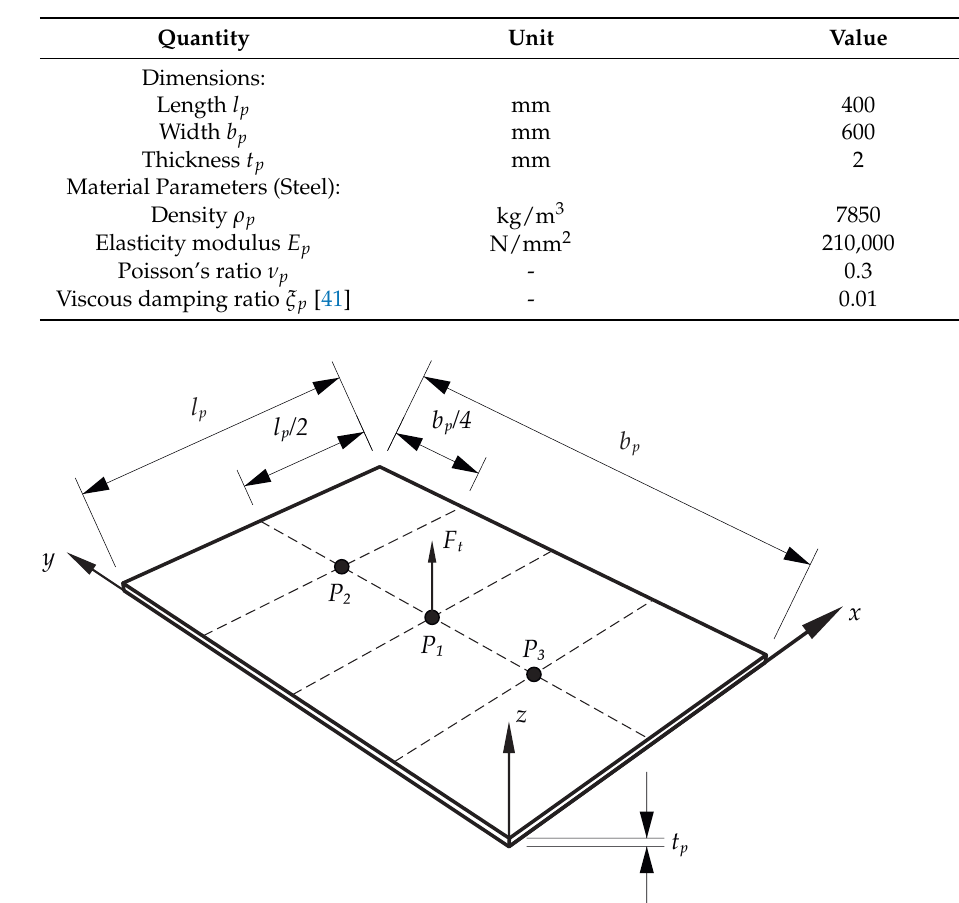
Figure 3. Model of the vibrating plate with its dimensions, characteristic points P 1 to P 3 for displace- ment evaluation and force application as well as an exemplary force F t